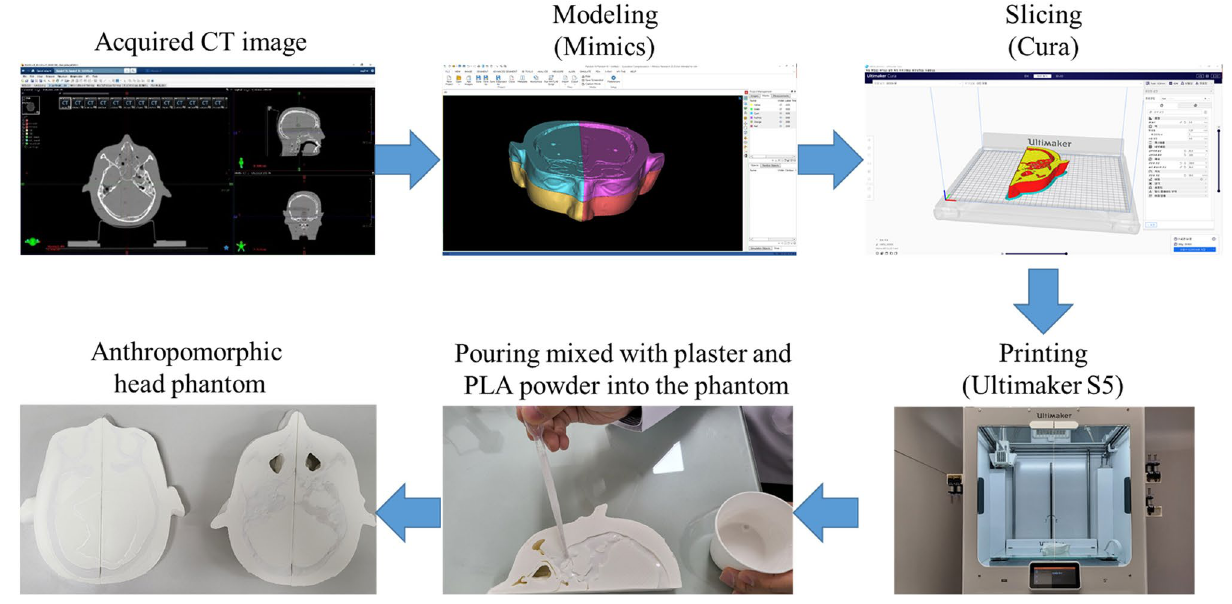
Figure 1. Workflow for preparing a phantom composed of plaster mixed with PLA